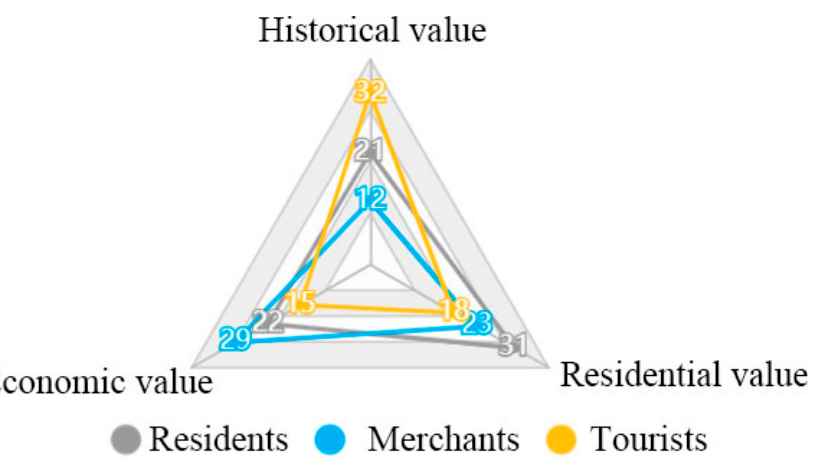
Figure 6. Analysis of the value identification of Nantou Ancient City by the multi public.